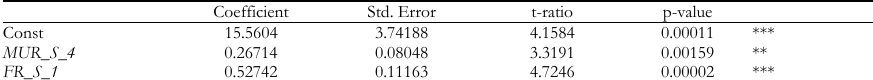
OLS in Southern regions of Italy (adj. R 2 =